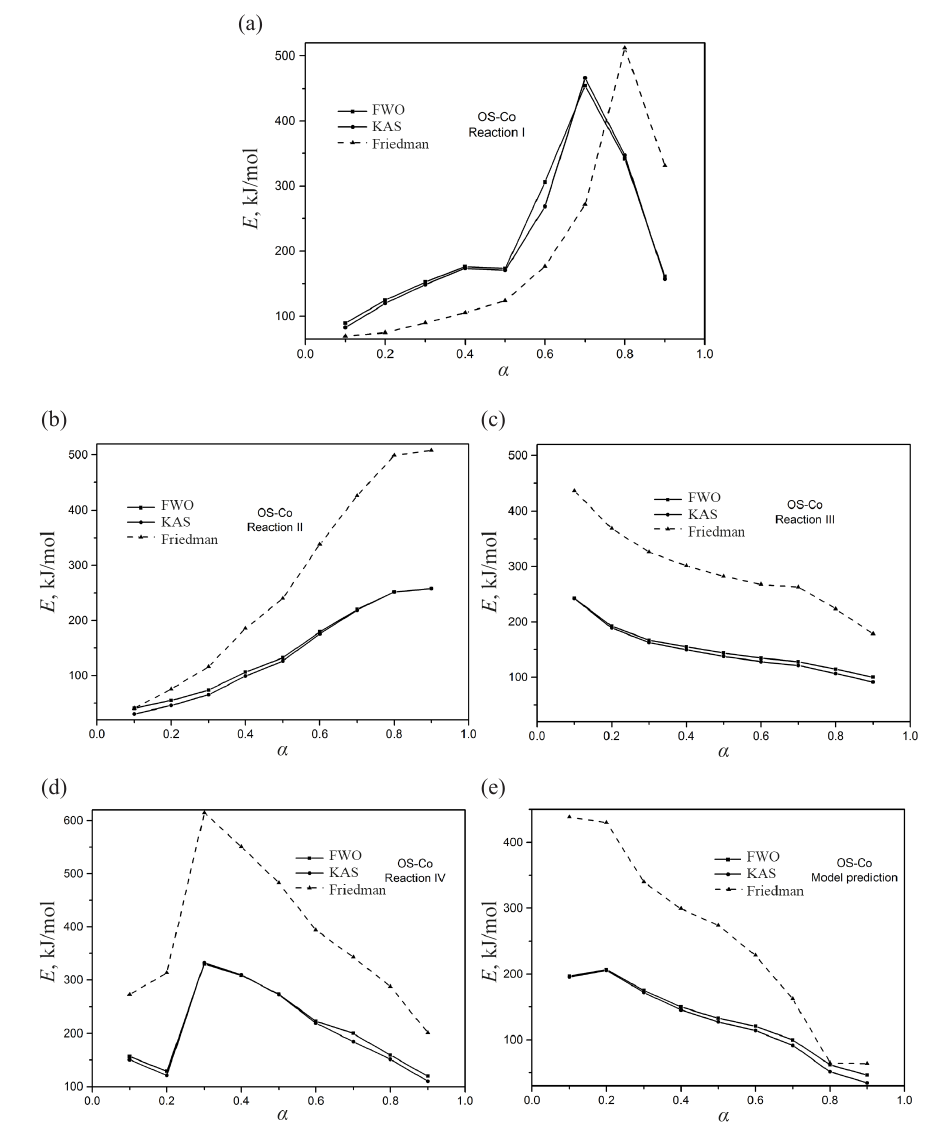
Fig. 5. Relationship between the activation energy and conversion rate of OS-Co samples at different stages and sub-peaks: (a) comparison of activation energies of Reaction I calculated by different methods; (b) comparison of activation energies of Reaction II calculated by different methods; (c) comparison of activation energies of Reaction III calculated by different methods; (d) comparison of activation energies of Reaction IV calculated by different methods; (e) comparison of activation energies of the fitting curve fitting curve calculated by different